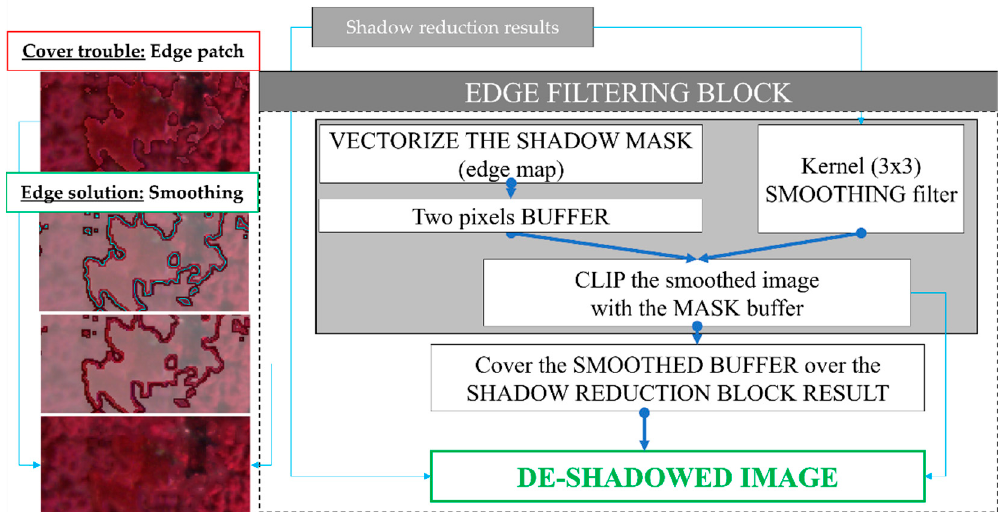
Figure 7. Edge filtering step methodology workflow: the cover problem is a patching pattern of de-shadowed pixels over the original image. To solve this, the shadow mask is vectorized, a two-pixel buffer is applied, and used to clip a smoothed raster of the patched image. This clip is overlayed again on the patched image to smooth the transition between the de-shadowed and the non-shadowed pixels.